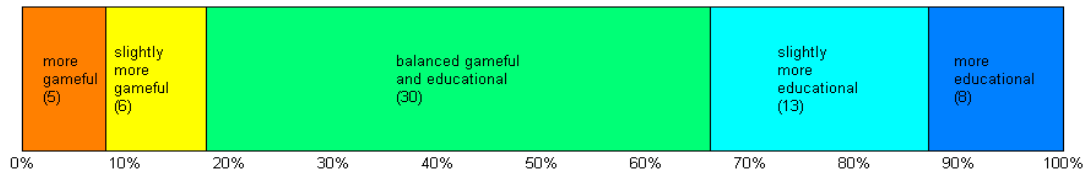
Figure 8. Average scores of individual responses to System Usability Scale (SUS) statements.